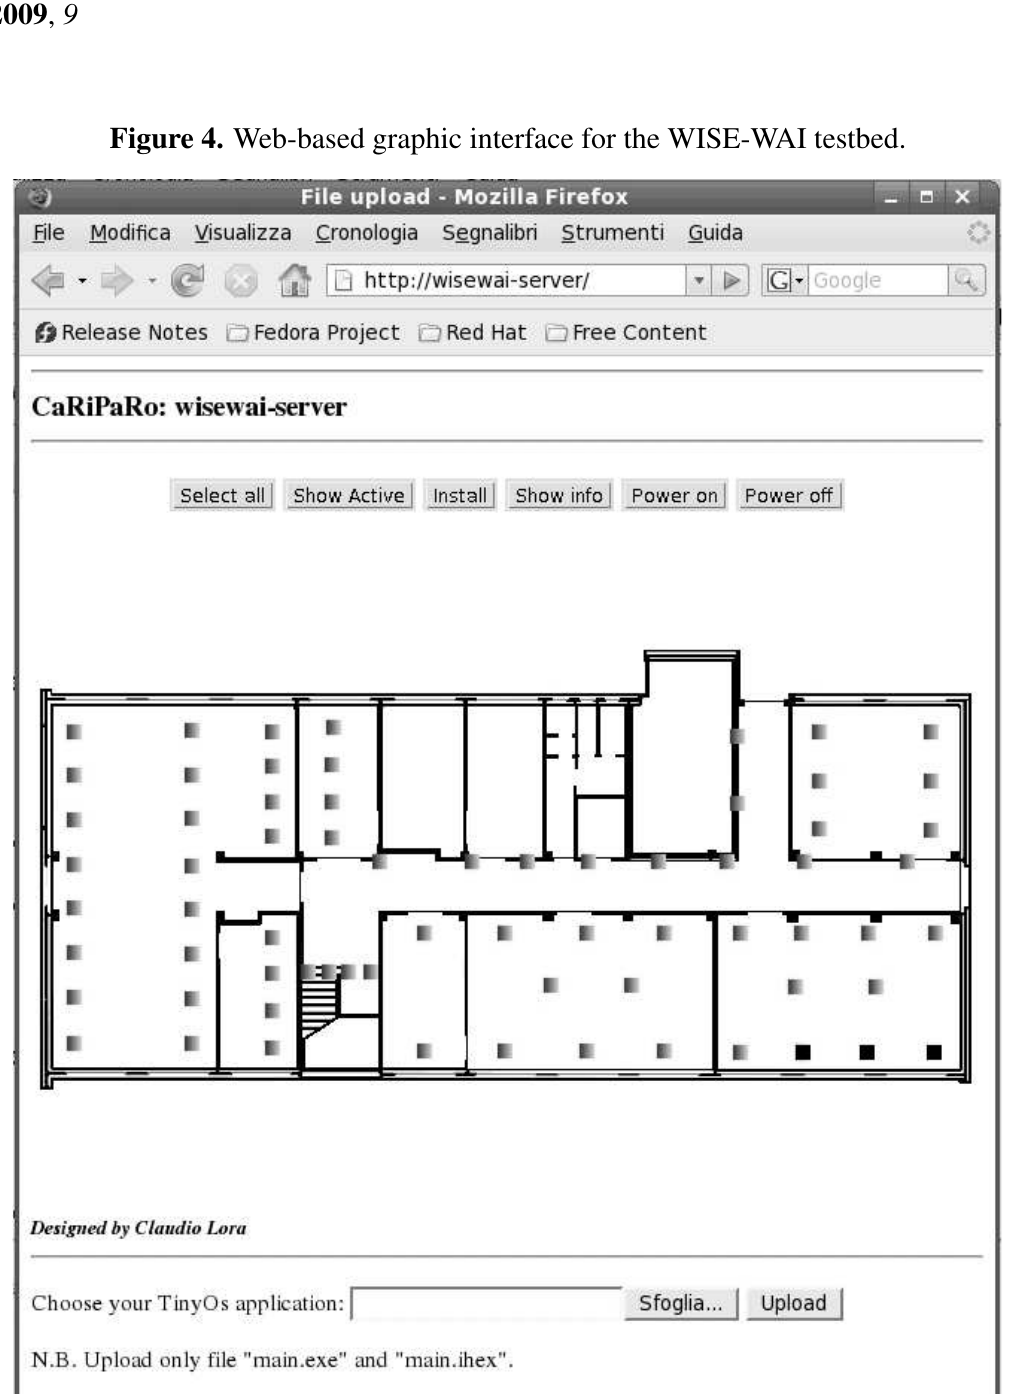
Figure 4. Web-based graphic interface for the WISE-WAI